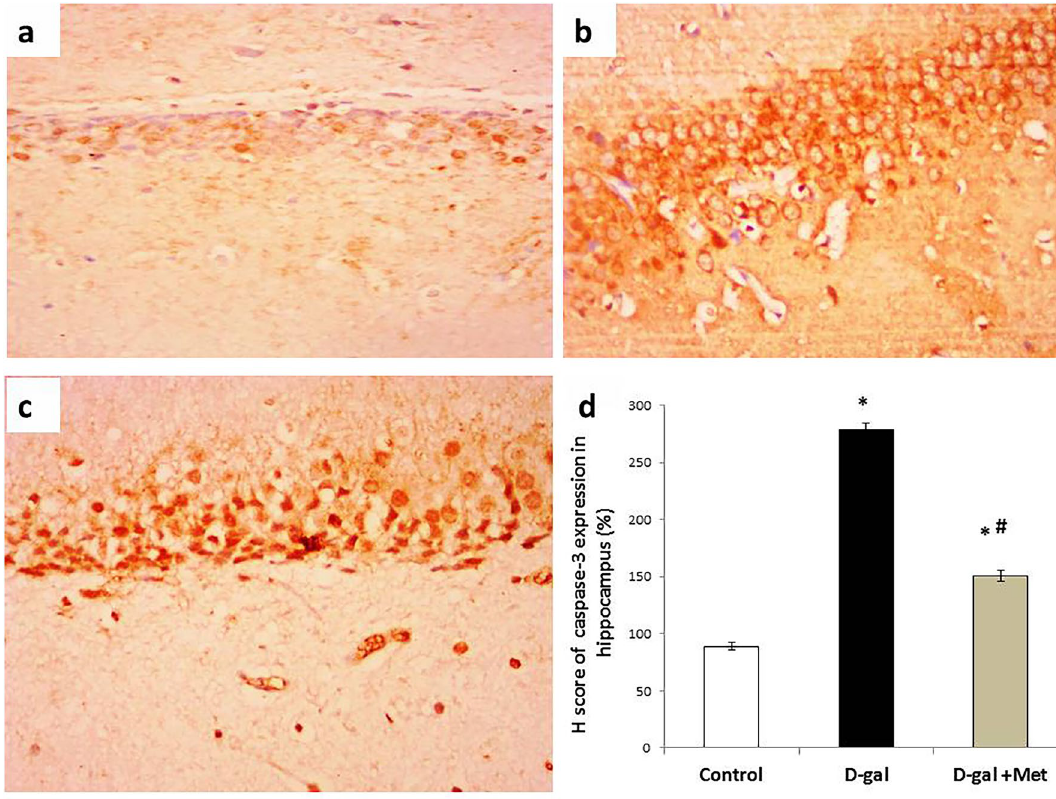
Figure 9. Caspase-3 immunostaining in hippocampal tissues of the studied groups. ( a ) Section of the hippocampal tissue in the control group showed mild cytoplasmic expression of Casepase-3 in glial and neural cells. ( b ) Section of the hippocampal tissue in the D-gal group showed marked cytoplasmic expression of synaptophysin in neural cells. ( c ) Section of the hippocampal tissue in the D-gal + Met group showed moderate nucleocytoplasmic expression of Casepase-3 in neural cells (Casepase-3 × 200 for A, B and C). ( d ) Represents the percentage of Casepase-3 expression in the above-mentioned groups (*significant when compared to control group, # significant when compared to D-gal group). Data are shown as means + SD (n = 10). ANOVA was used to make group comparisons; Significance = P <